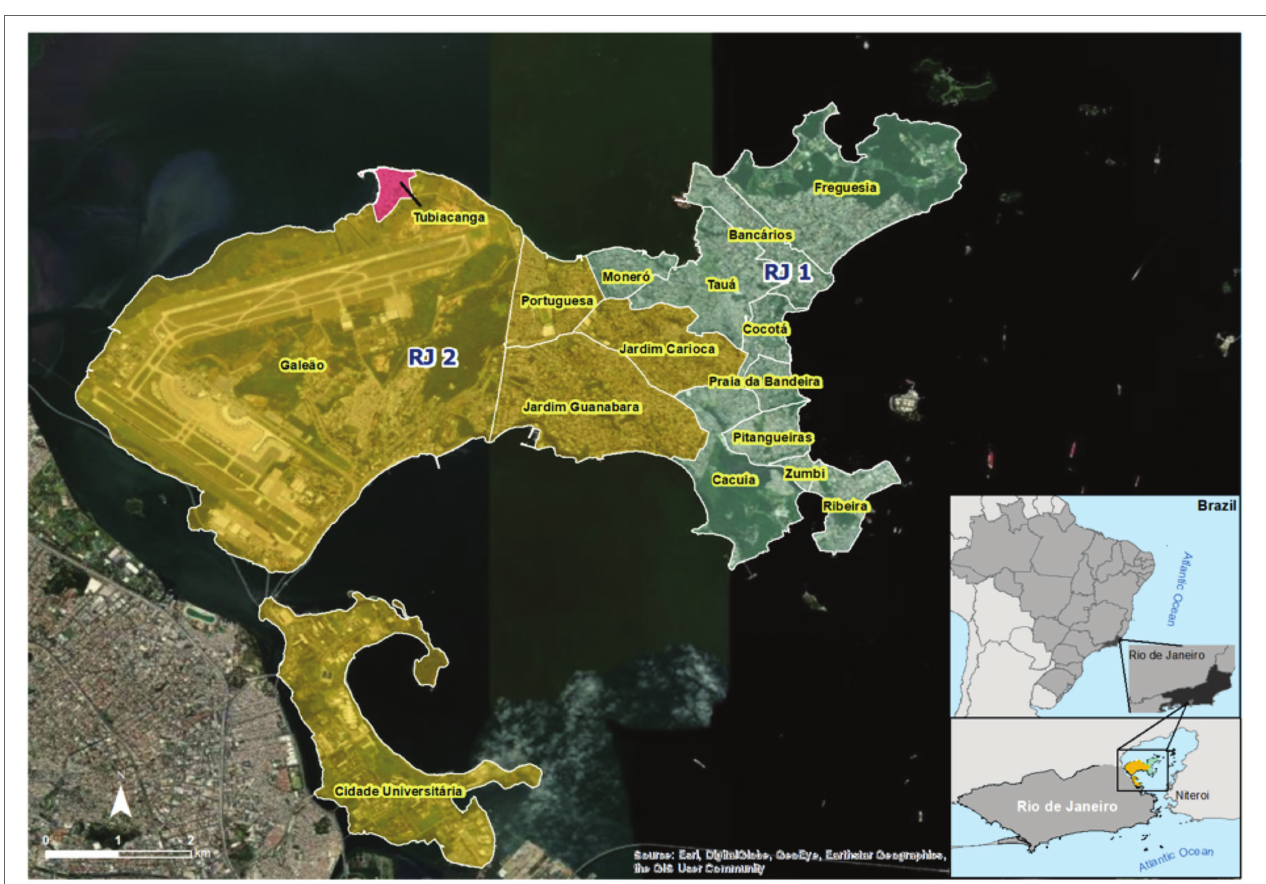
FIGURE 1 | Map of Ilha do Governador intervention areas and neighborhoods. Satellite view of Ilha do Governador area, the largest island of Guanabara bay, in northern Rio de Janeiro (RJ). With an estimated total population of 211,018 in 40 km 2 , Ilha do Governador is divided into the following neighborhoods: Bancários, Cacuia, Cocotá, Freguesia, Monero, Pitangueiras, Praia da Bandeira, Ribeira, Tauá, Zumbi, Cidade Universitária, Galeão, Jardim Carioca, Jardim Guanabara, and Portuguesa. For Wolbachia release intervention, neighborhoods were grouped into two great areas, RJ1 (green) and RJ2 (yellow). Note that Cidade Universitária is actually located in an adjacent island, Ilha do Fundão, which is under the same public administration zone of Ilha do Governador and was therefore included as part of the RJ2 area. Also depicted is Tubiacanga (red), a small neighborhood, which was targeted in a pioneer release